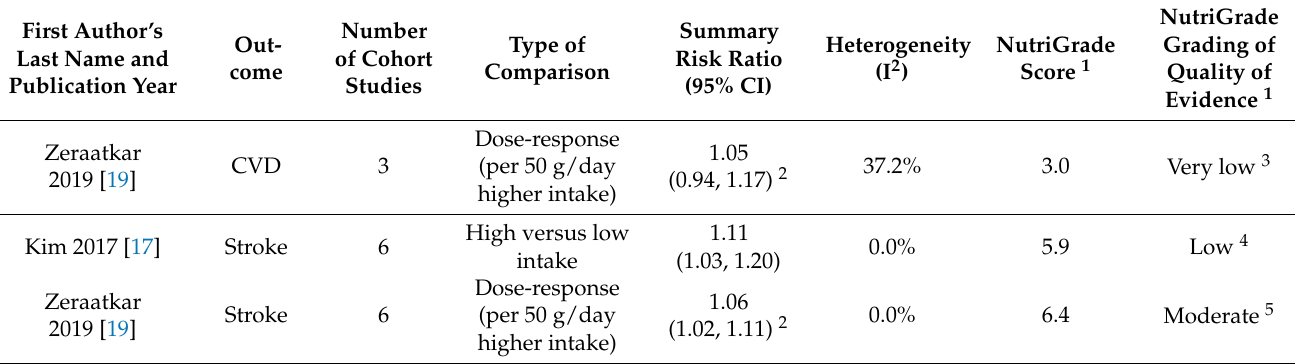
Table 4. Meta-analyses of associations between intake of unprocessed red meat and risk of CVD and stroke, and NutriGrade meta-evidence